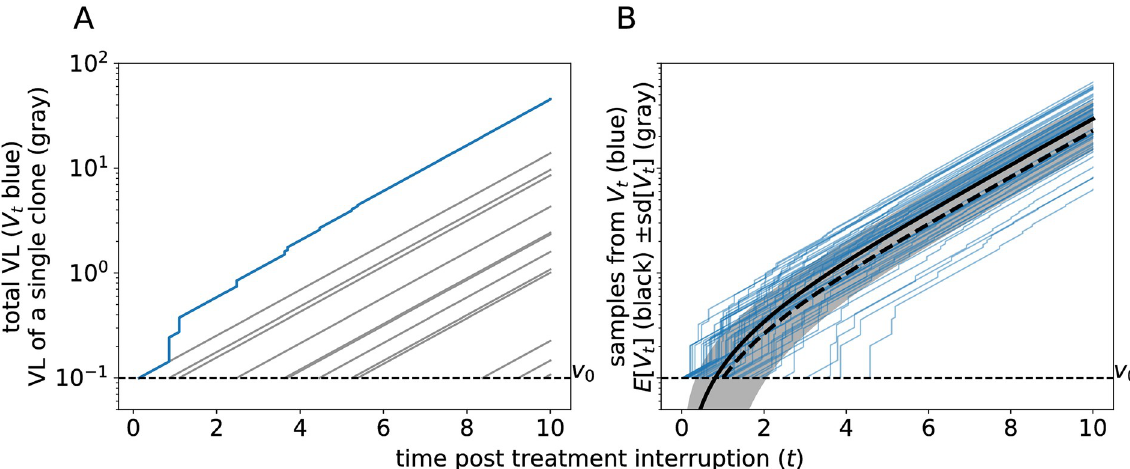
Fig 1. Simulations of the multiple-reactivation model. (A) Graphical representation of Eq 1. The gray lines indicate the exponential growth curves of individual clones that originated from a single successful reactivation from the latent reservoir. The blue curve represents the total VL, i.e. the sum of the gray lines. (B) Comparison between the expectation of the process V (in black) and realizations sampled from this process (in t blue). The mean ± standard deviation (sd) of V is shown as a gray band. The dashed thick curve corresponds to the approximation ~ V with t 0 = t t 1/ λ d. Parameters: g = 0.5 d − 1 , λ = 1.0 d − 1 , and v 0 = 0.1 copies mL −